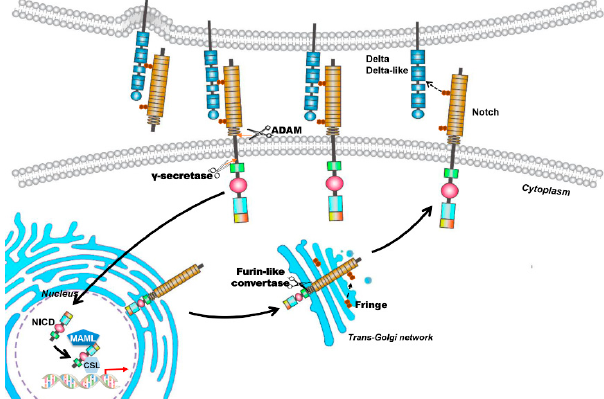
Figure 1. The canonical Notch signaling pathway. Mammal Notch family members are composed of four Notch transmembrane receptors (Notch-1, Notch-2, Notch-3 and Notch-4) and five typical transmembrane ligands (Delta-like 1, Delta-like 3 and Delta-like 4, Jagged-1 and Jagged-2). Notch receptors are synthesized as single-chain precursors and transported to the Golgi apparatus (Black arrow points to the Golgi apparatus). In the Golgi apparatus, the precursors are cleaved into an extracellular and a transmembrane subunit by furin and modified by glycosyltransferases Fringe. Then the matured proteins are transported and inserted into cell membrane (Black arrow points to the cell membrane). Interaction between Notch receptors and their ligands triggers the canonical Notch signaling pathway. The transmembrane Notch receptor is cleaved by a disintegrin and metalloproteinases (ADAM) to remove the extracellular subunit, and then, a multisubunit membrane protease γ -secretase catalyzes the second proteolytic cleavage that gives rise to the translocation of the Notch intracellular domain (NICD) into the nucleus (Black arrow points to the nucleus). In the nucleus, NICD binds with a transcription factor (Black arrow in the nucleus), RBP-J κ (also known as CSL for CBF1/Su(H)/Lag-1), coactivator Mastermind-like (MAML) proteins, and forms an activated transcriptional complex. Then, the activated complex upregulates the expression of target genes (red arrow), such as hairy and enhancer of split (HES)-1, -5, -7 and HES-related repressor protein (HERP)-1 to -3. The deep blue pentagon represents coactivator MAML protein and the light blue hexagon represents transcriptional factor CSL. The orange arrows indicate cleavage sites; the arrow with dotted line in Golgi aparatus indicates protein glycosylation by Fringe and the arrow with dotted line between Notch ligand and receptor indicates the interaction of the two proteins.